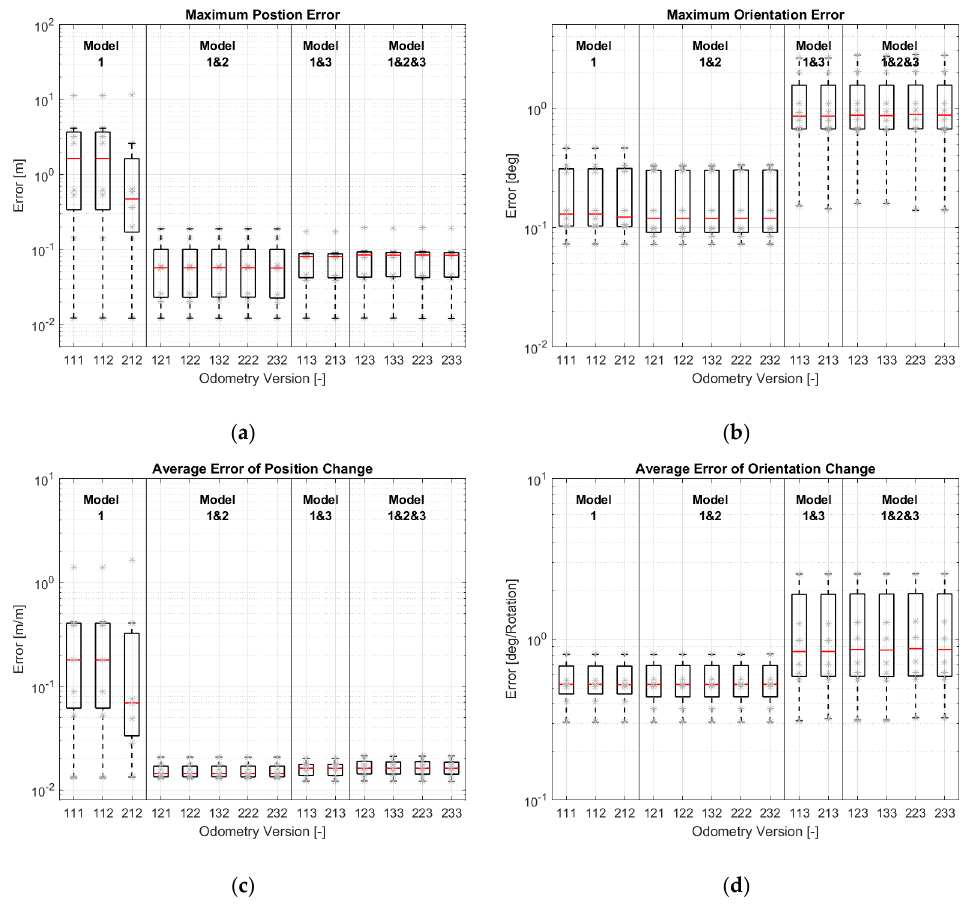
Figure 19. Simulations results of different odometry versions: ( a ) Maximum position errors; ( b ) Maximum orientation errors; ( c ) Average errors of position change; ( d ) Average errors of orientation change.